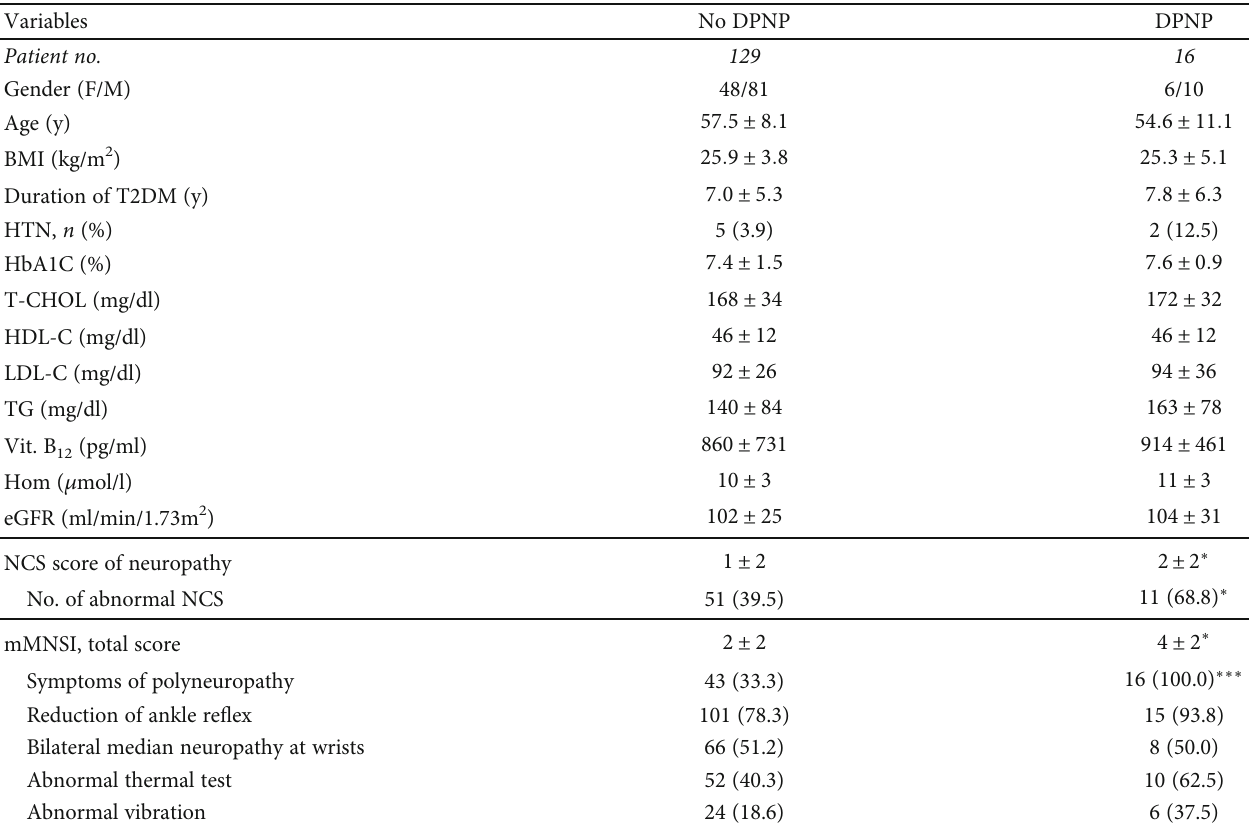
Table 4: Demographic characteristics, neurologic examinations, and electrophysiologic studies of patients with or without DPNP a . Variables No DPNP DPNP Patient no.